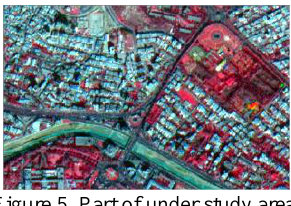
Figure 5. Part of under study area.